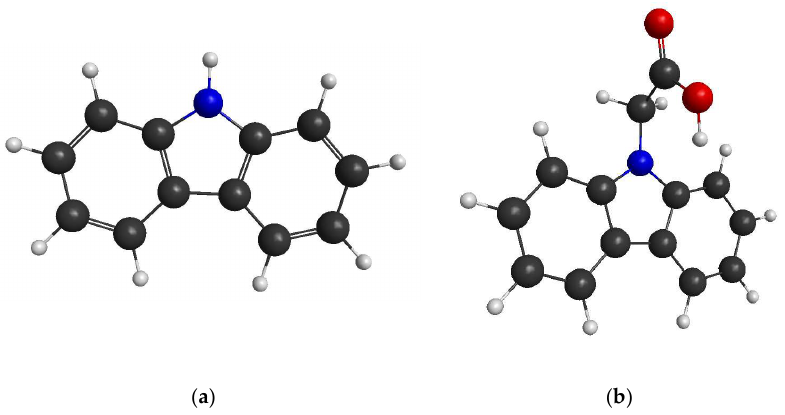
Figure 1. Structure of carbazole ( a ) and 2-(9H-carbazol-9-yl)acetic acid ( b